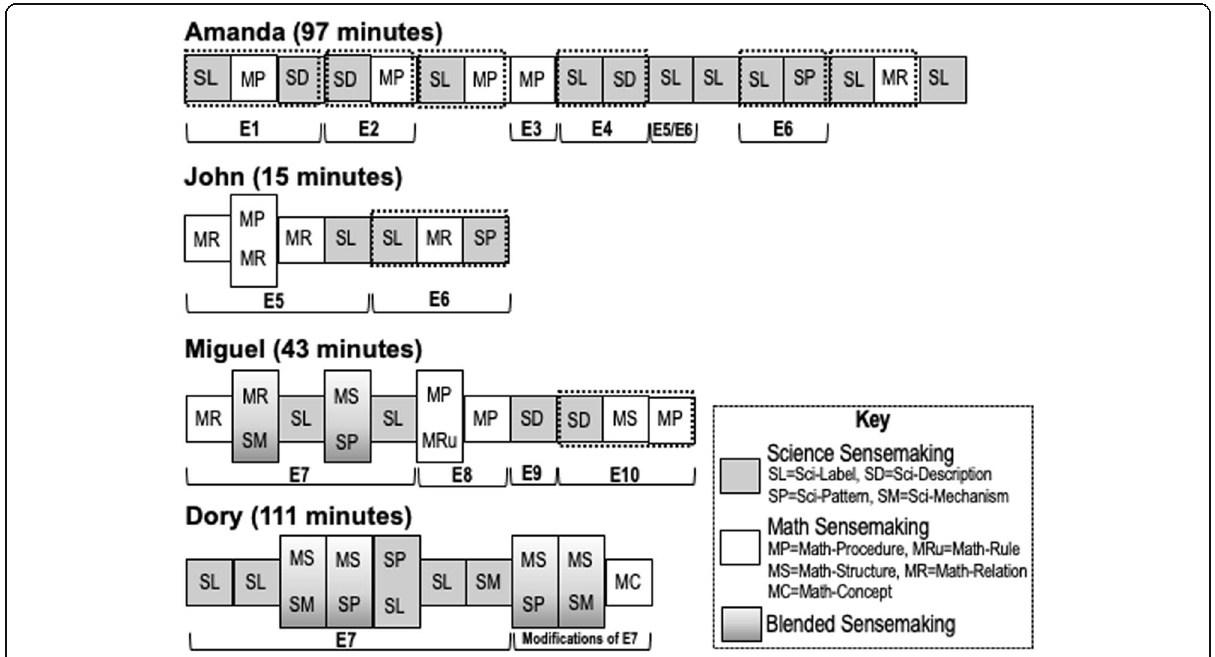
Fig. 5 The organization of sensemaking opportunities identified during each instructor ’ s lesson on equations about population growth. The types of sensemaking opportunities are presented in sequential order. Mathematics sensemaking is placed in a white box, and science sensemaking is placed in a gray box. Sensemaking opportunities that co-occurred are placed in a single box. A gradient background indicates a co-occurrence of sensemaking from both mathematics and science dimensions. Each sensemaking type corresponds to a single activity except where a dotted box indicates that different types of sensemaking opportunities occur in the same activity. E = Equation. Amanda has several periods of sensemaking that are not associated with a specific equation. During these times she was summarizing the lesson, either as students transitioned to a new activity or to wrap up the class. Instructional time is not represented in the